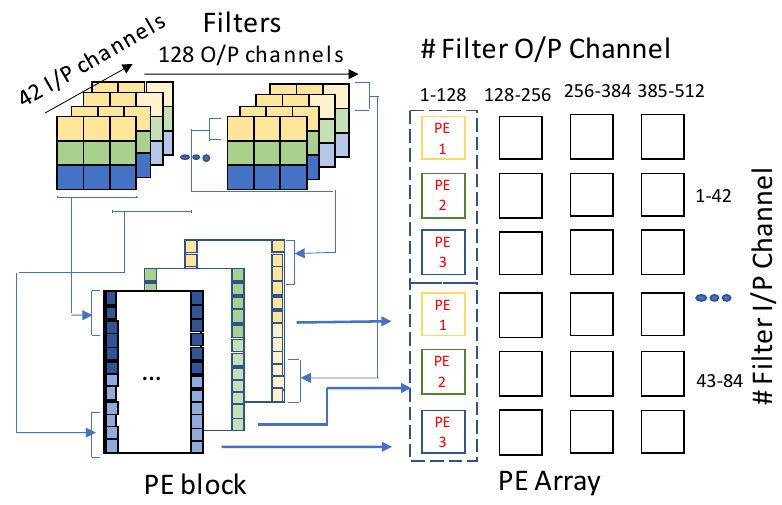
Figure 17. The row-disjoint filter mapping technique proposed in [21].